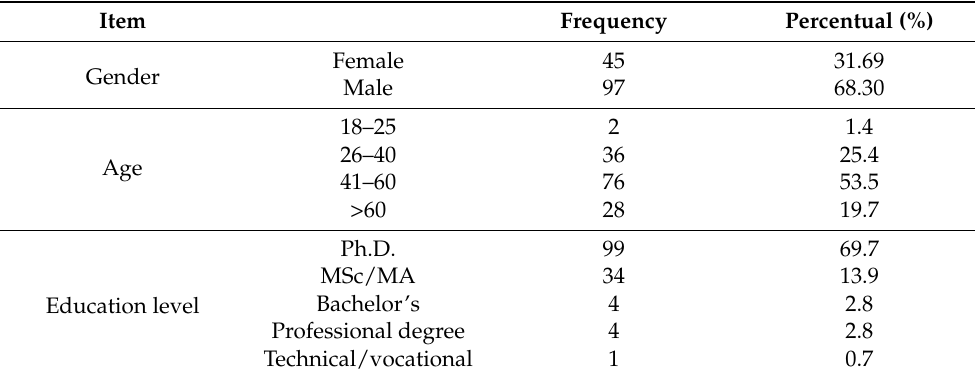
Table 2. Professional and gender profiles of